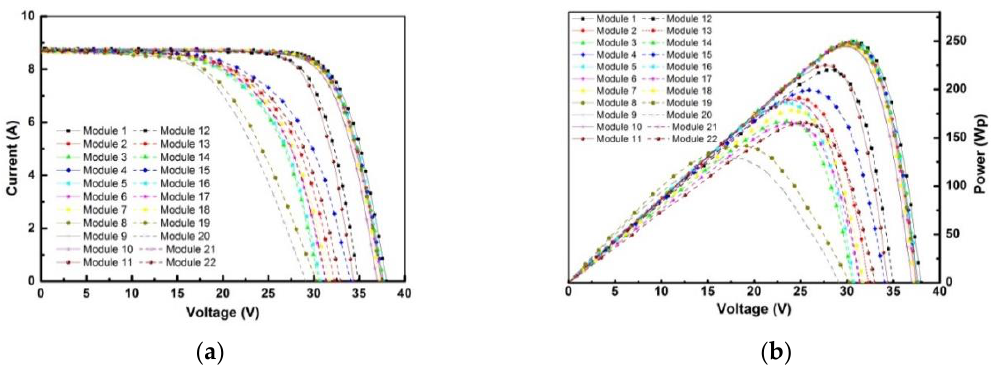
Figure 8. The current-voltage characteristics ( a ) and power-voltage characteristics ( b ) of 22 multicrystalline silicon solar modules dismounted from PID-affected module string 1. Solar module 20 shows the largest performance deterioration with power degradation of 48% and open circuit voltage degradation of 23%, respectively.